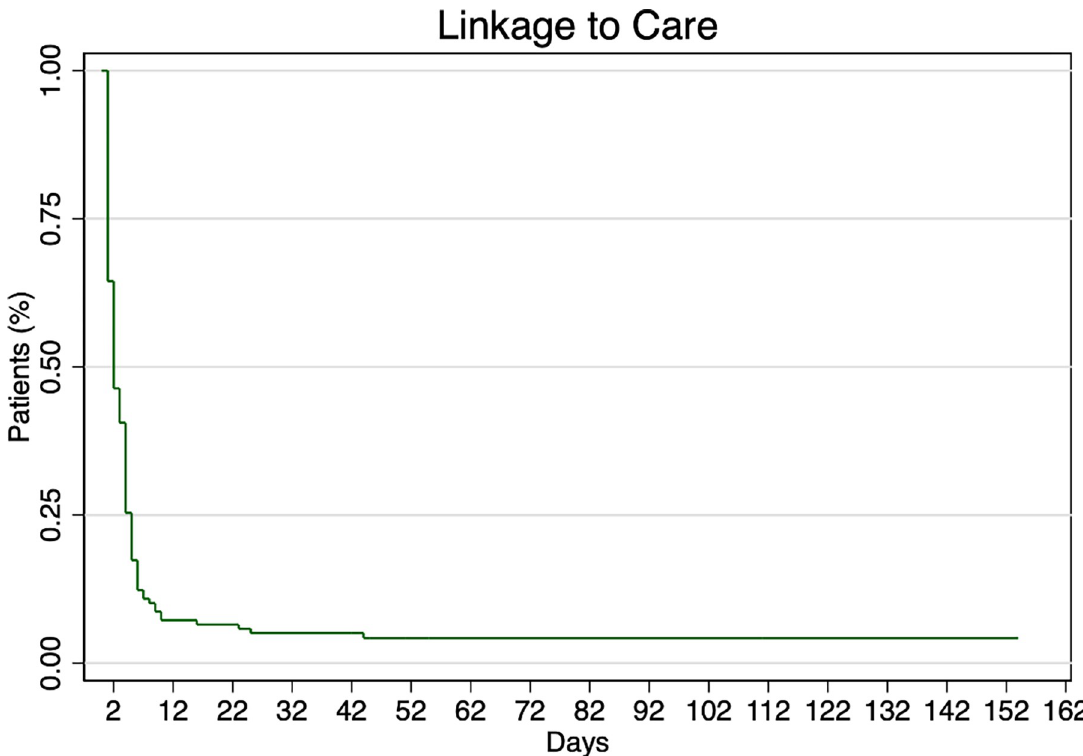
Fig 1. Linkage to care. Kaplan-Meier curve for the outcome linkage to care, as measured by the date of the first documented VL result in the EMR. Time in days is calculated from the date of the first positive HIV test. The curve shows the percent of patients that do not yet have a VL result at each time point.